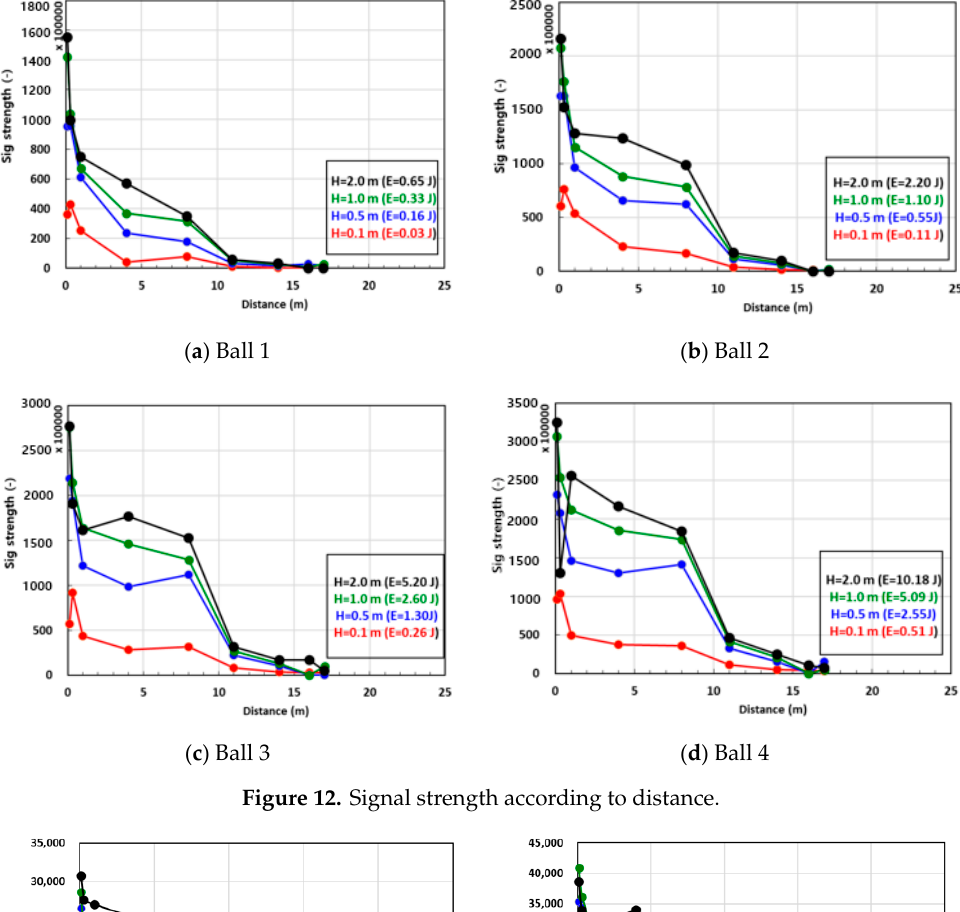
Figure 12. Signal strength according to distance.